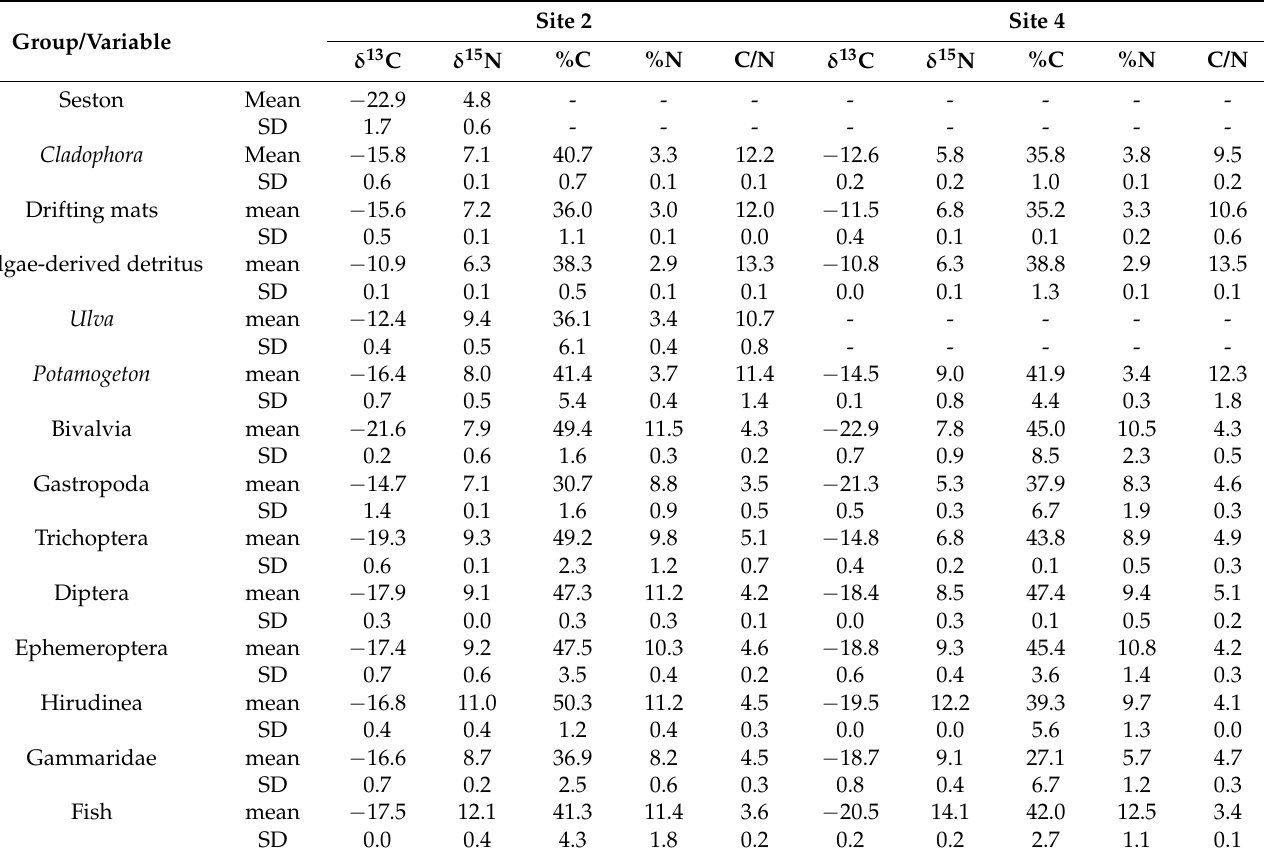
Table 2. Isotopic composition of carbon and nitrogen ( δ 13 C and δ 15 N values), total carbon (C), and nitrogen (N) content and mass ratio of C/N of the members of coastal food webs at sites 2 and 4. n = 5 for primary producers and detritus, n = 4 for